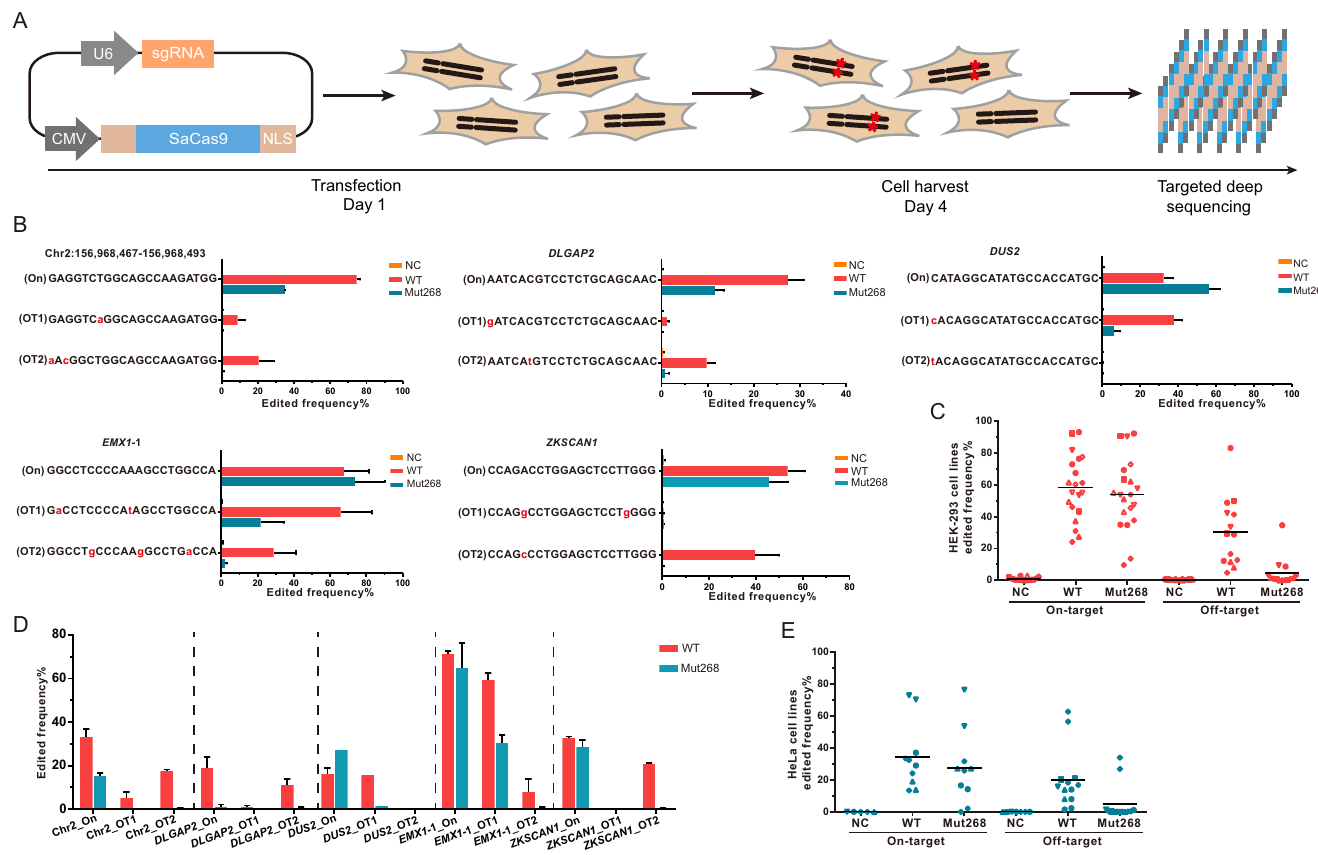
Fig 2. Fidelity validation of improved specificity for Mut268 at ten endogenous loci. (A) Illustration of CRISPR-SaCas9-mediated genome editing at endogenous genes. Ten endogenous-targeted sites were selected for fidelity test. (B) WT and Mut268 mediated cleavage at on-target and predicted off-target sites. Cleavage efficiency was examined by targeted deep sequencing. Edited products containing nucleotides substitution, in/del were analyzed. Mismatched nucleotides in predicted off-target sites are highlighted in red. The data underlying this figure can be found in S3 Data. Error bars, SEM; n = 2. (C) Comparison of WT and Mut268 for the enhanced specificity in HEK-293 cell lines. All 10 on-target sites were plotted to compare the on-target activity between WT and Mut268. Off-target sites edited by WT SaCas9 with obvious off-target effects and Mut268 were plotted. Sample size of 10 in on-target sites and 7 in off-target sites. (D) WT and Mut268 mediated cleavage at on-target and predicted off-target sites in HeLa cells; error bars, SEM; n = 2. (E) Comparison of WT and Mut268 for the enhanced specificity in HeLa cells. in/del, insertion/ deletion; NC, negative control (without transfection of Cas9-expression plasmid); “On,” on-target; OT, predicted off-target; SaCas9, Staphylococcus aureus Cas9; WT,